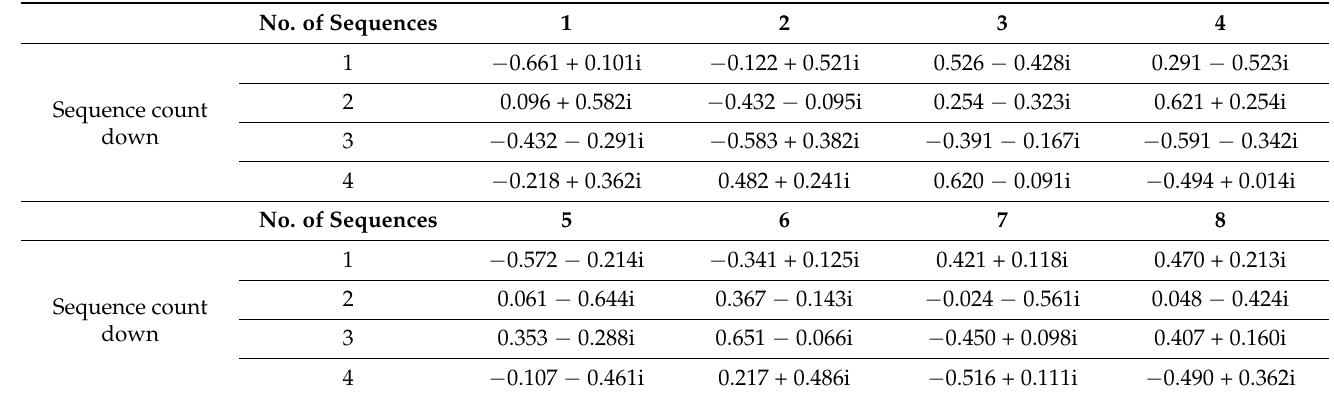
Table 1. A set S of WBE sequences from the 3GPP report.